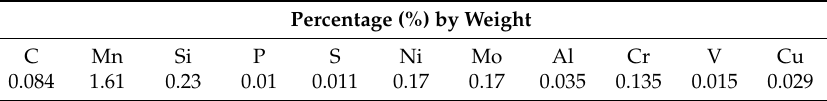
Table 1. Chemical composition of the API 5L X80 steel.